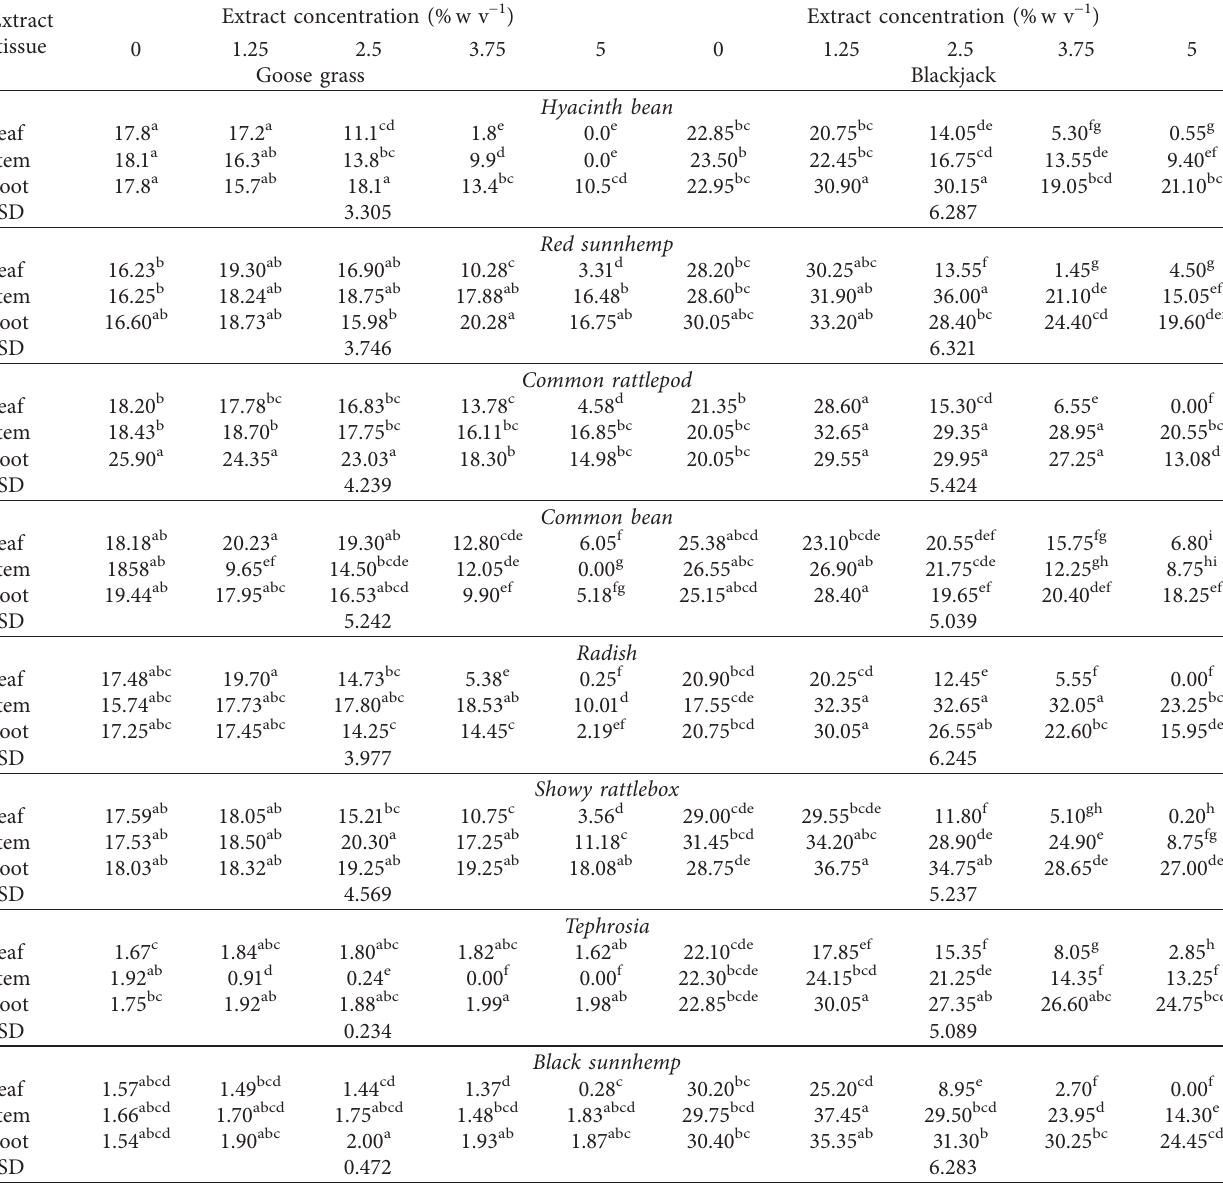
Table 5: Effect of aqueous extracts of eight green manure cover crops on the plumule length of goose grass and blackjack.